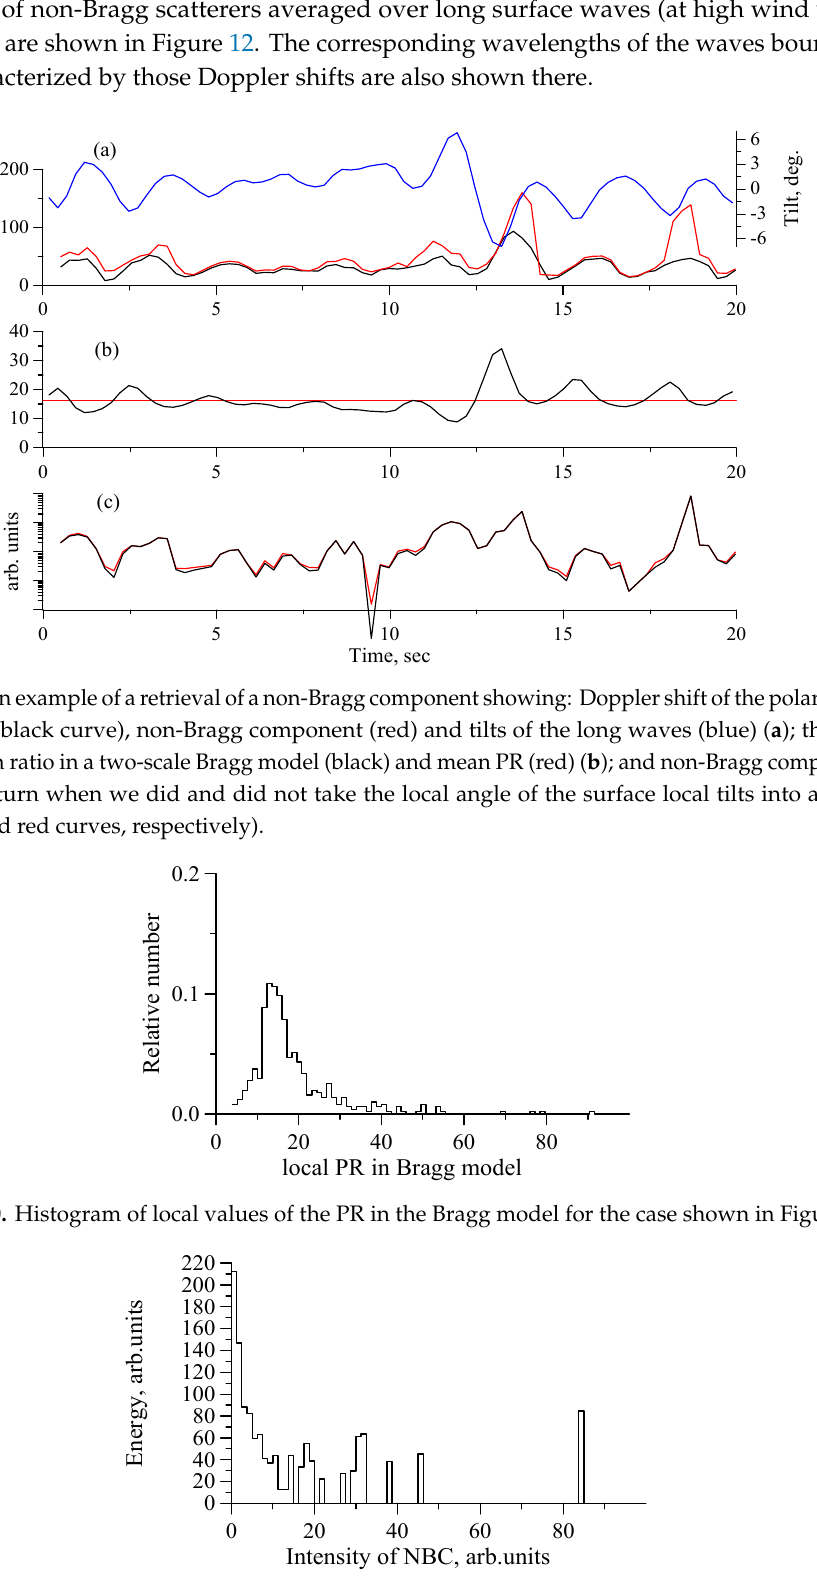
Figure 11. Energy of local non-Bragg component (NBC) contained in a given intensity range vs. NBC intensity for the case shown in Figure 5.